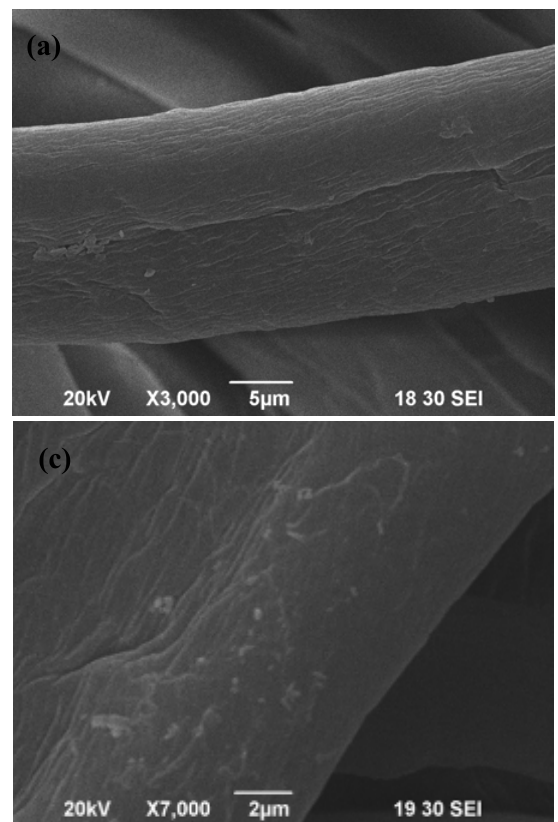
Figure 2. S ample without plasma pre-treatment: ( a ) M1; ( b ) M2 [5]; ( c ) M3 [5]; and sample with plasma pre-treatment: ( d ) PM1 [6]; ( e ) PM2 [6]; ( f ) PM3